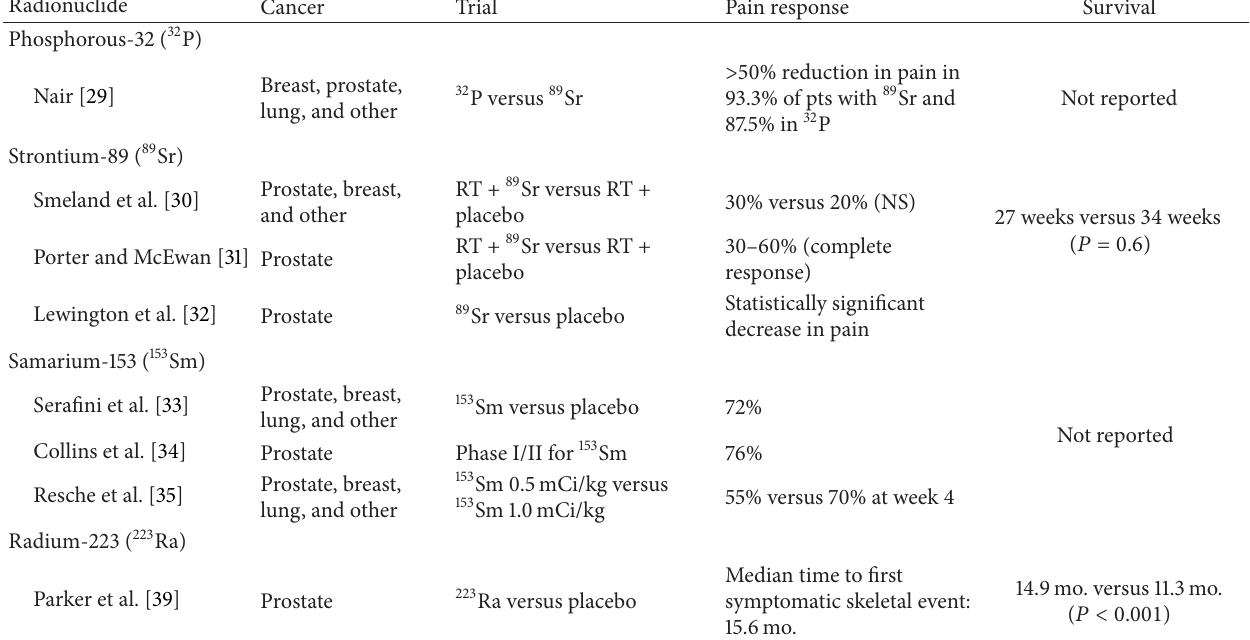
Table 3: Summary of clinical trials evaluating